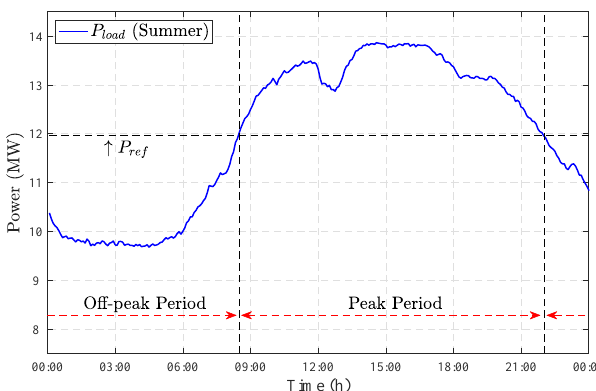
Figure 8. Daily load profile of the feeder for summer season.